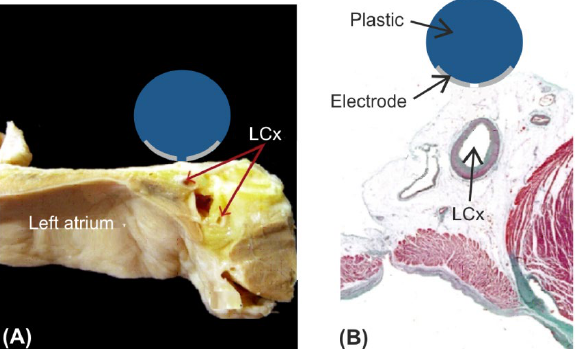
Figure 1. Physical situation modelled in the study. Anatomical picture ( A ) and histological image ( B ) showing the spatial relation between the ablation electrode and the left circumflex coronary artery –LCx–.Reprinted adapted with permission from [10]. Copyright © 2014 Damián Sánchez-Quintana et al. (it is an open access article distributed under the Creative Commons Attribution License (Attribution 3.0 Unported (CC BY 3.0)).